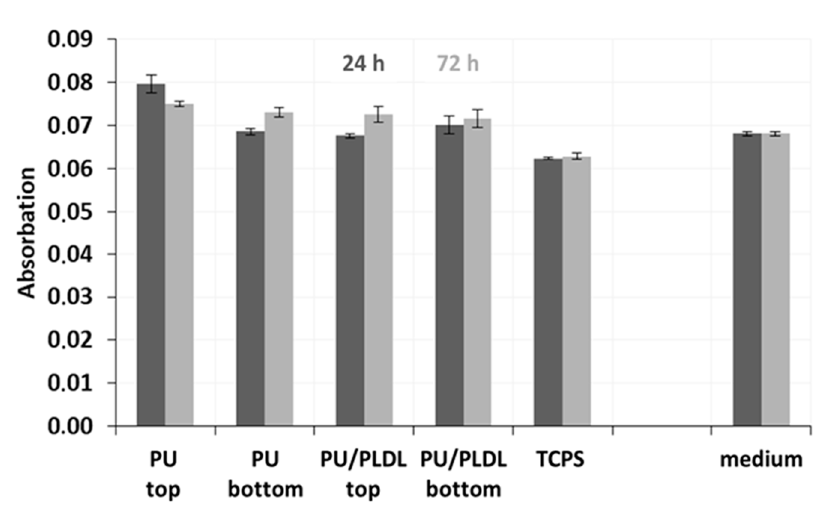
Figure 11. Nitric oxide (NO) production by mice fibroblast NIH 3T3 during the first and third day of cell culture in the PU and PU/PLDL 8/2 sponges.